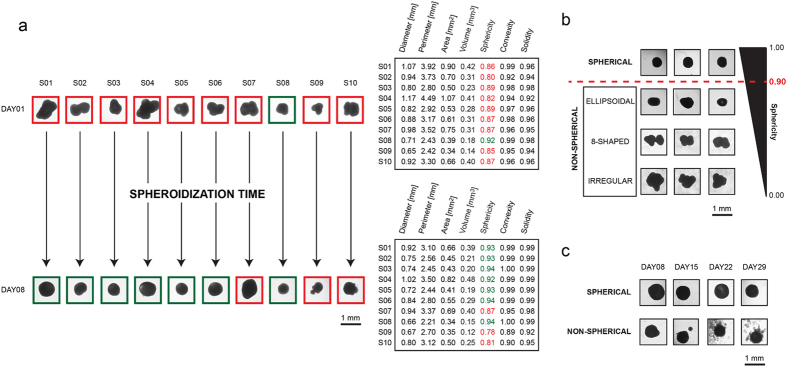
Spheroid-shape heterogeneity and evolution over time.(a) Very few spheroids generated by the RCCS method initially have a spherical shape (brightfield images of A549 3D cultures obtained using an Olympus inverted microscope with attached Nikon high speed DS-Vi1 colour digital camera, scale bar = 1 mm). After approximately one week of culture (spheroidization time), the majority can be considered as a real “spherical” spheroid (SI ≥ 0.90). (b) After the spheroidization period, a number of morphological classes of spheroids can still be observed: spherical, ellipsoidal, Figure 8-shaped and irregular. (c) We observed that the spherical-shaped spheroids generally maintain their morphology over time. Conversely, spheroids with a non-spherical shape after spheroidization are characterized by substantial morphological changes (i.e. cell detachment, budding of secondary spheroids).